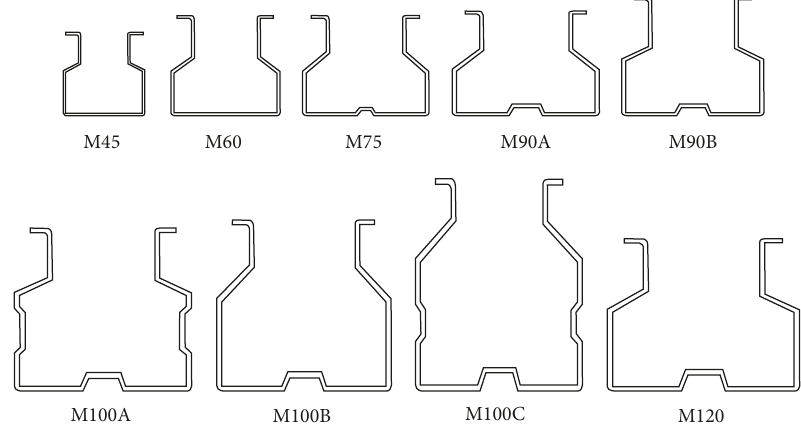
Figure 4: Nine series specimen for column tests.